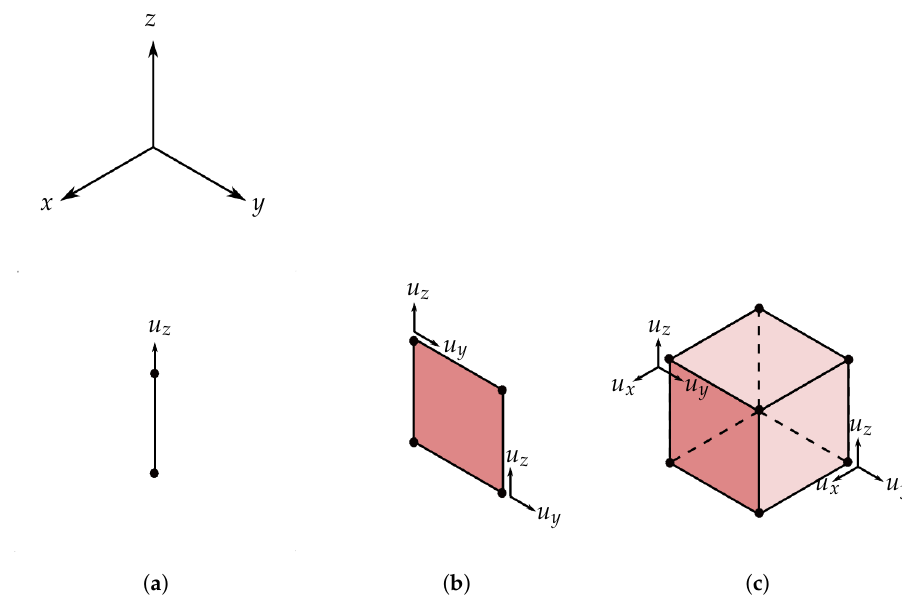
Figure 1. ( a ) 1D, ( b ) 2D, and ( c ) 3D elements with the corresponding displacement DOFs at each node